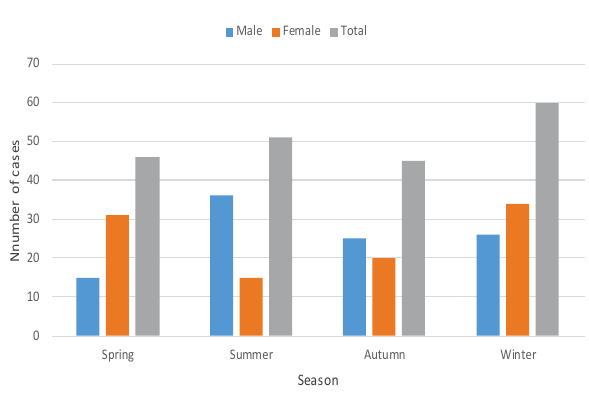
Figure 5. Patient distribution according to age group and cause of burn